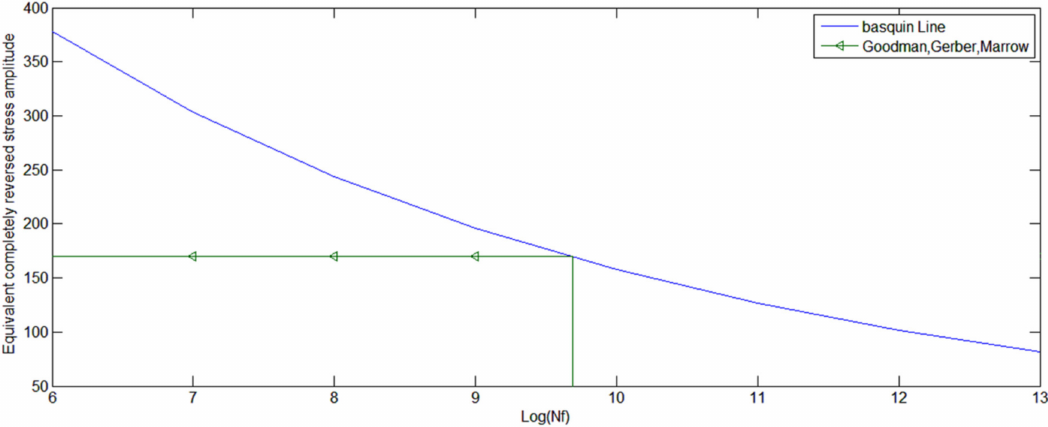
Figure 14. Plot of σ ar (principal stress)-Log (N f ) for different models describing the implant. Considering Figure 13 and employing the Basquin relationship, the implant life was predicted within the range of 10 8 to 3 × 10 9 cycles. This was in accordance with ISO14801, where a 10 6 -cycle life is recommended for